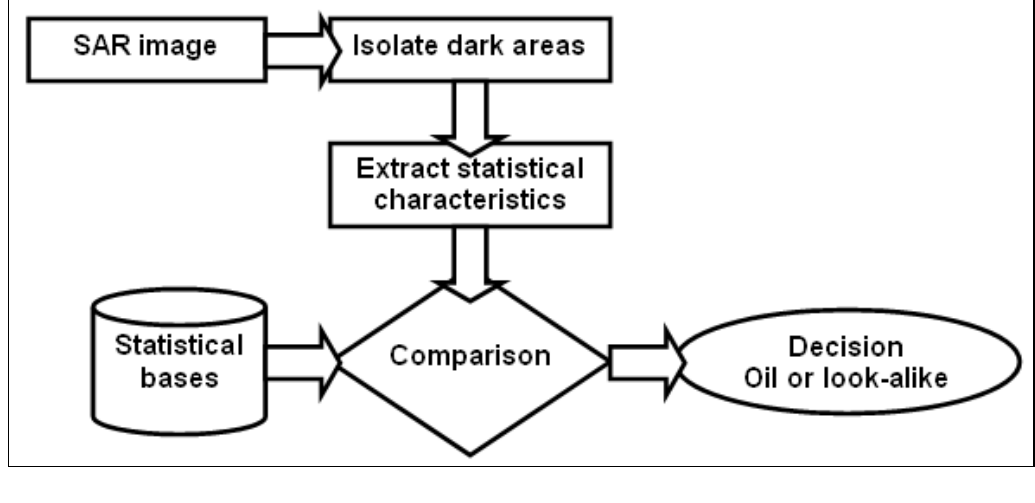
Figure 3. The basic functions of oil spill detection